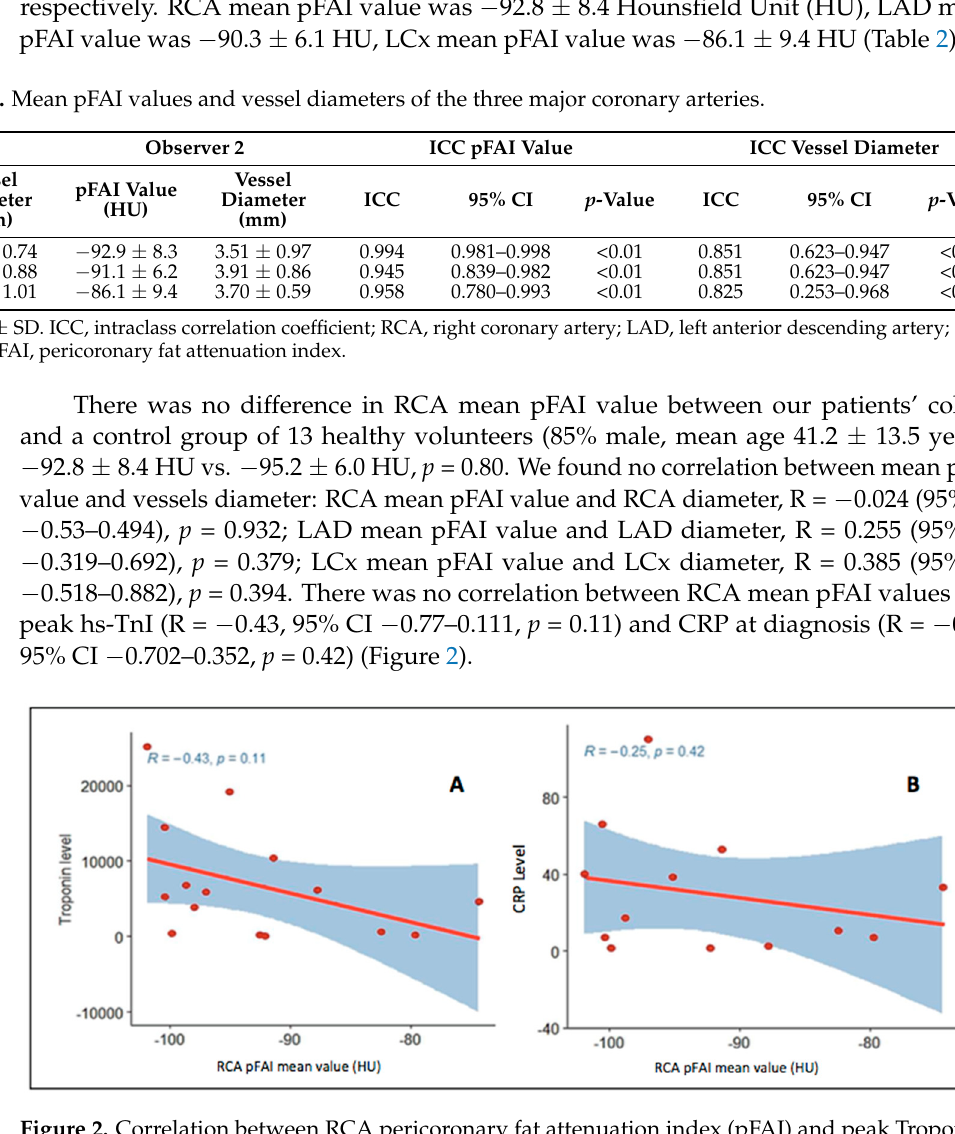
Figure 2. Correlation between RCA pericoronary fat attenuation index (pFAI) and peak Troponin I ( left panel) and C reactive protein (CRP) levels ( right panel) at diagnosis.